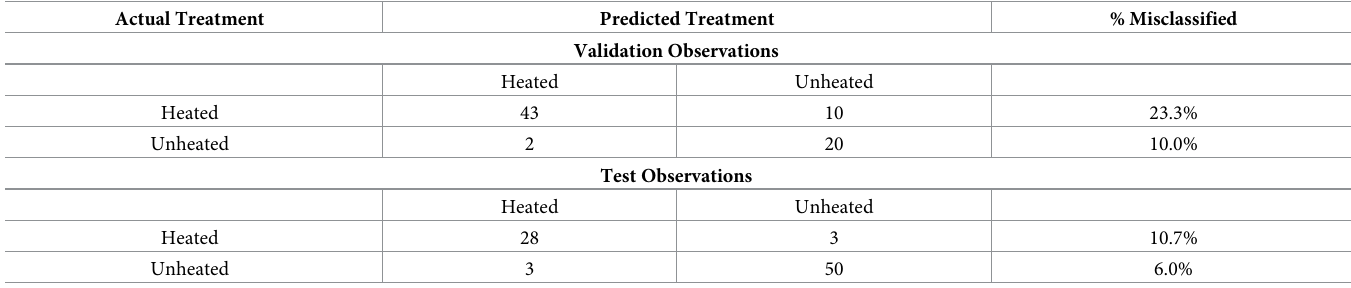
Table 12. k-NN model D observation-level prediction